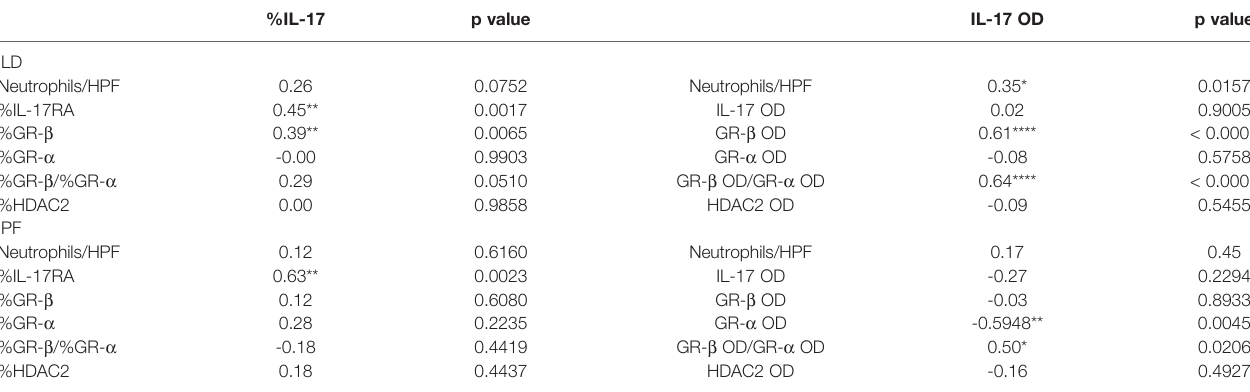
TABLE 2 | Correlations between IL-17 and staining fi ndings (neutrophil counts, IL-17, GR- b , GR- a , GR- b /GR- a , HDAC2). %IL-17 p value IL-17 OD p value ILD